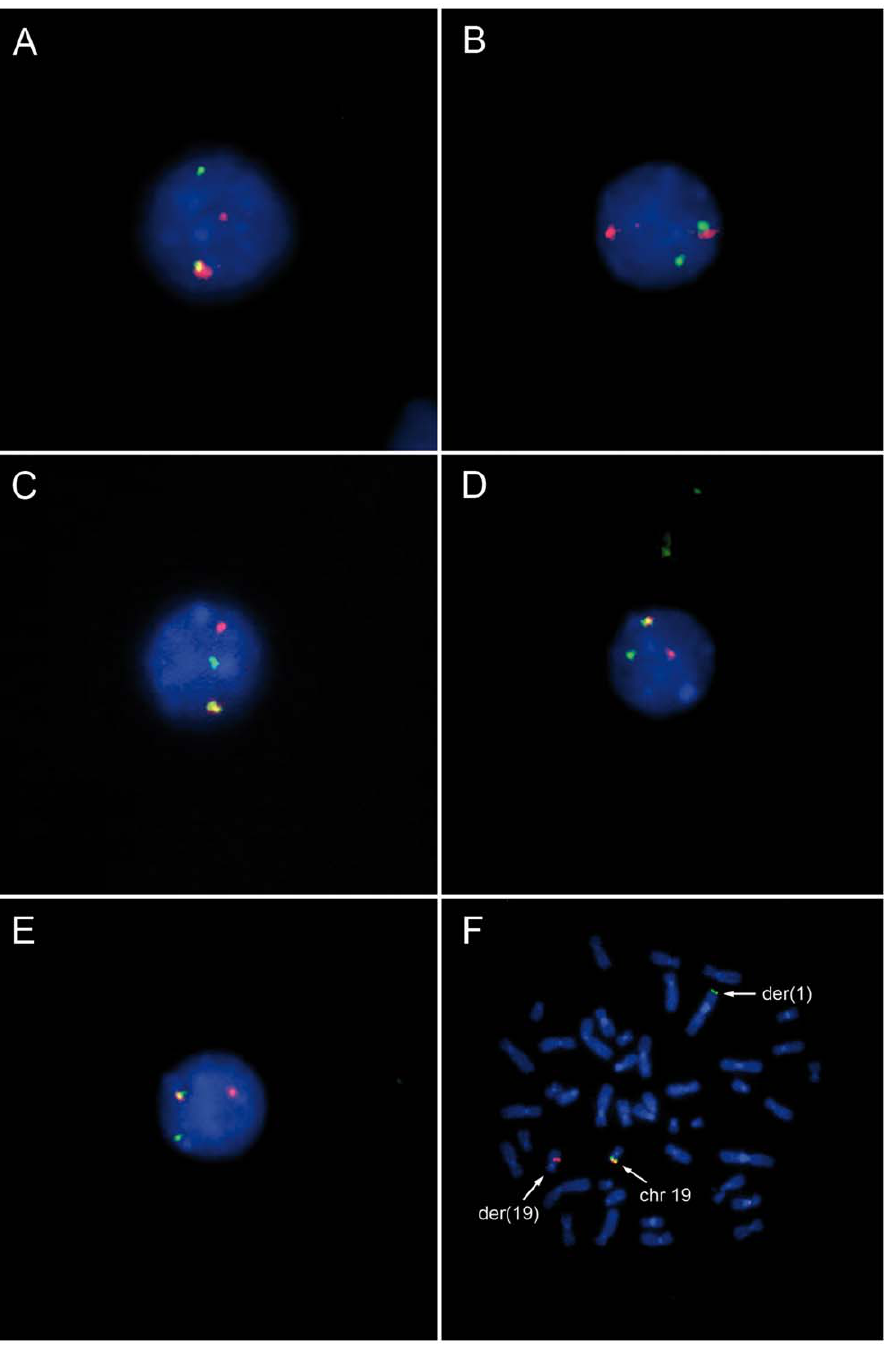
Figure 4. Fluorescence in situ hybridization (FISH) with dual-color, break-apart rearrangement probe (tbpc19). ( A ) – ( E ) I-FISH showing 19q13 rearrangements detected using touch-preparations of five thyroid adenomas ( A: S801, B: S814, C: S842, D: S846, E: S849) indicated by separated green (3 9 -tbpc19) and red signals (5 9 -tbpc19); ( F ) Metaphase of case S842 with a t(1;19)(q32;q13) after FISH with tbpc19. The 19q13 rearrangement is indicated also by separated signals on der(1) and der(19).